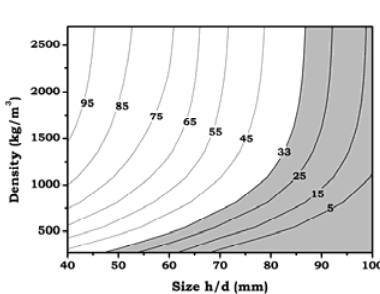
Figure 13. Predicted cooling velocity (in the critical temperature range), at central point, for cylinders of different size and